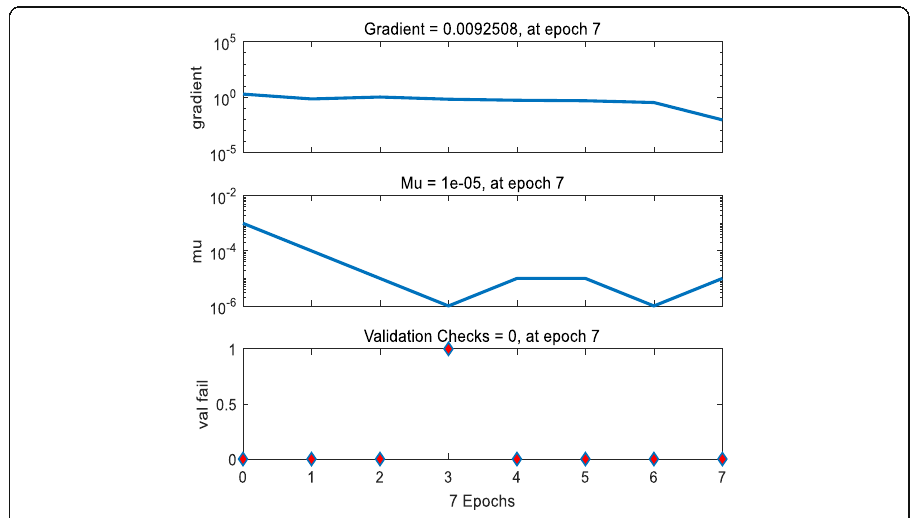
Fig. 5 BP neural network training state